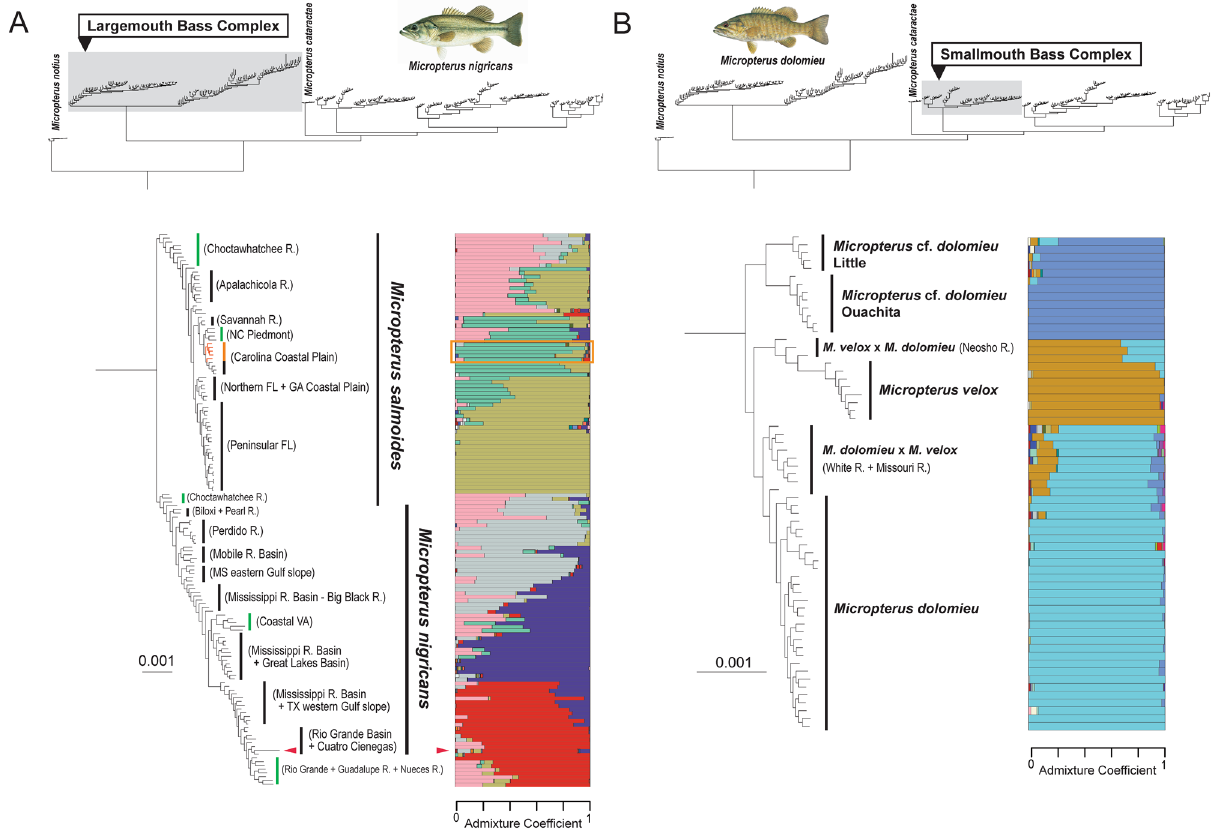
Figure 2. Maximum likelihood phylogeny inferred from IQ-TREE analysis of concatenated ddRAD dataset for ( a ) the Largemouth Bass complex and ( b ) the Smallmouth Bass complex. Population structure (K = 20) inferred from snmf analysis for each species complex are shown to the right of the phylogeny. In the clade delimiting the Largemouth Bass complex ( a ), population structure assignments and branches leading to specimens from the vicinity of Charleston, South Carolina (type locality of Micropterus salmoides ) are highlighted in orange. Green vertical bars indicate populations of genetic admixture between M. nigricans and M. salmoides that are identified in TreeMix analysis. Red arrows indicate the phylogenetic placement and population structure assignment of a specimen sampled from Cuatro Ciénegas. See Supplementary Fig. S1 for a completely annotated phylogeny tip labels and bootstrap supports values. Illustrations © Joseph R. Tomelleri, used with